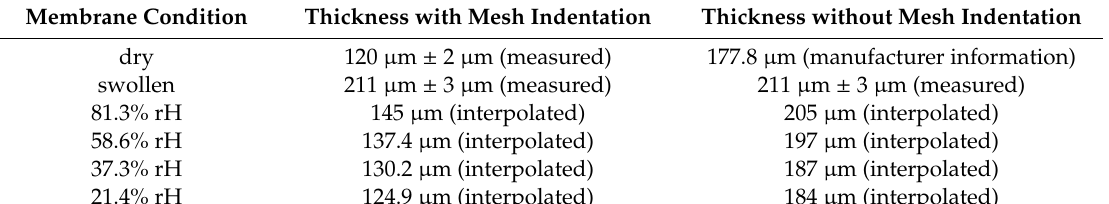
Figure 8. Indentations of the Pt mesh into the electrolyte membrane; ( a ) Nafion 117 after disassembly; ( b ) SEM micrograph of a cross section; and ( c ) SEM micrograph of the electrolyte surface.